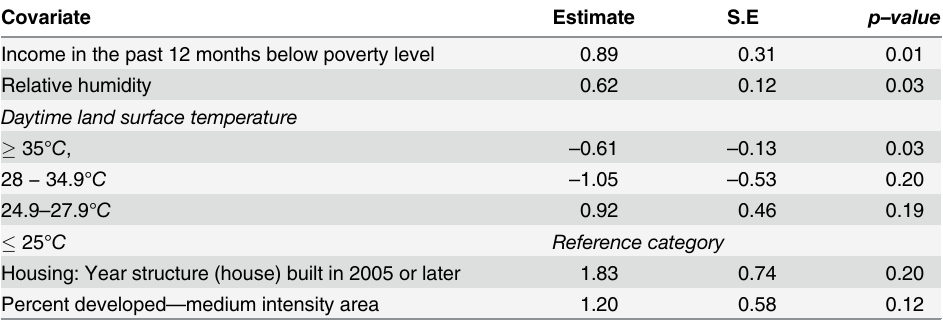
Table 4. Results of bivariate regression analysis and candidate variables ( p (cid:1) 0.2). Covariate Estimate